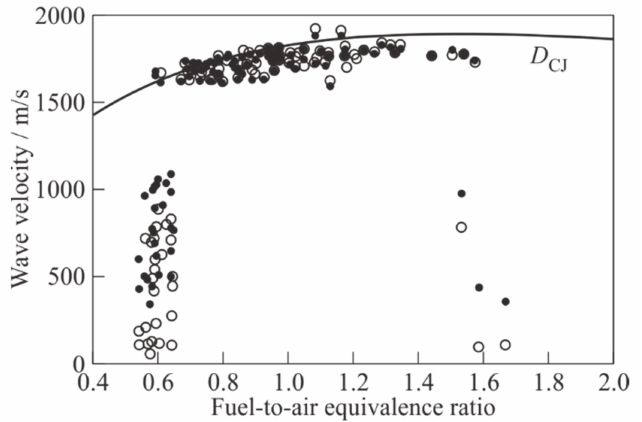
Figure 10. The cumulated experimental dependences of the average velocities of the SW (dark circles) and the flame front (open circles) in the measuring section of the PDT on the fuel-to-air equivalence ratio in the pyrogas–air mixtures. The solid curve corresponds to the CJ detonation velocity D CJ in a homogeneous ethylene–air